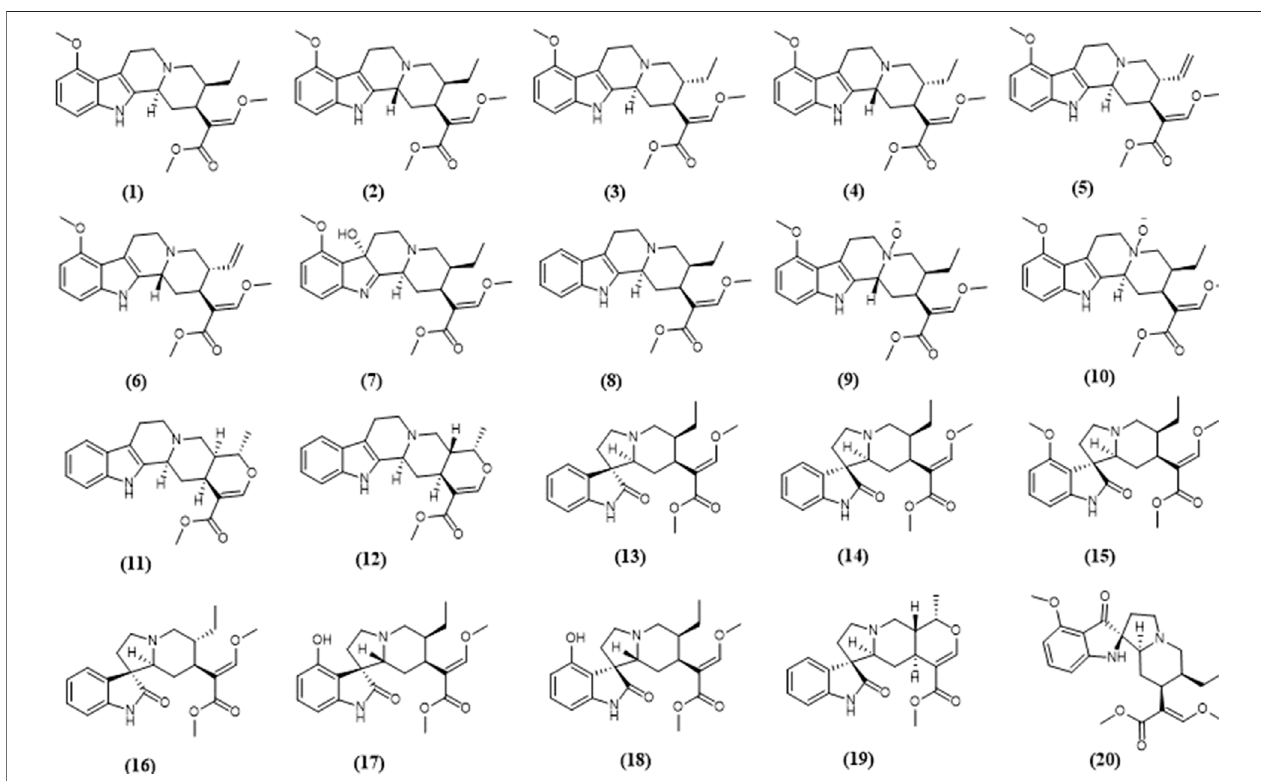
FIGURE 1 | Chemical structures of selected kratom alkaloids — ( 1 ) mitragynine, ( 2 ) speciociliatine, ( 3 ) speciogynine, ( 4 ) mitraciliatine, ( 5 ) paynantheine, ( 6 ) isopaynantheine, ( 7 ) 7-hydroxymitragynine, ( 8 ) corynantheidine, ( 9 ) speciociliatine n-oxide, ( 10 ) mitragynine n-oxide, ( 11 ) tetrahydroalstonine, ( 12 ) ajmalicine, ( 13 ) corynoxine, ( 14 ) corynoxine B, ( 15 ) mitragynine oxindole B, ( 16 ) isorynchophylline, ( 17 ) isospeciofoline, ( 18 ) speciofoline, ( 19 ) mitraphylline, ( 20 ) mitragynine pseudoindoxyl.